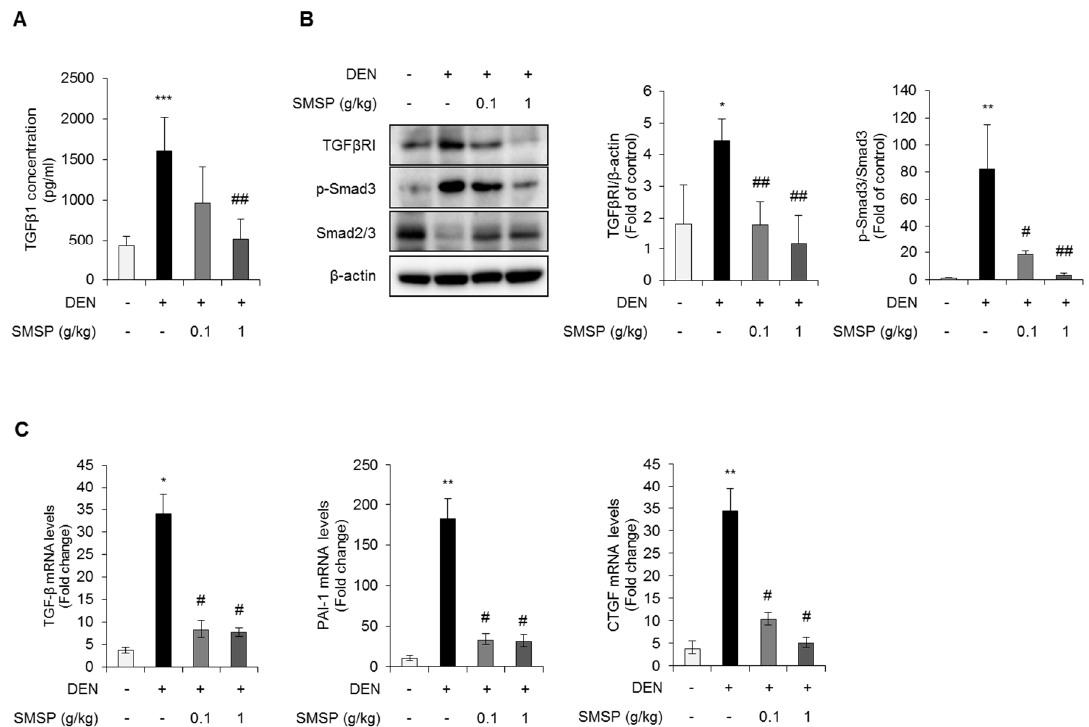
Figure 5. SMSP decreases transforming growth factor- β (TGF- β )-mediated signaling cascades in rats treated with DEN for 16 weeks. ( A ) Serum levels of TGF- β 1 were measured by ELISA. ( B ) The protein expression of TGF- β R, phopho-Smad3, and Smad3 were analyzed by Western blotting and relative protein expressions were quantified. ( C ) The mRNA expressions of TGF- β , PAI-1 , and CTGF were evaluated by qRT-PCR analysis. Results are presented as the mean ± SD. Statistical significance was analyzed by ANOVA. * p < 0.05, ** p < 0.01, and *** p < 0.001 compared to control; # p < 0.05 and ## p < 0.01 compared to the DEN group.